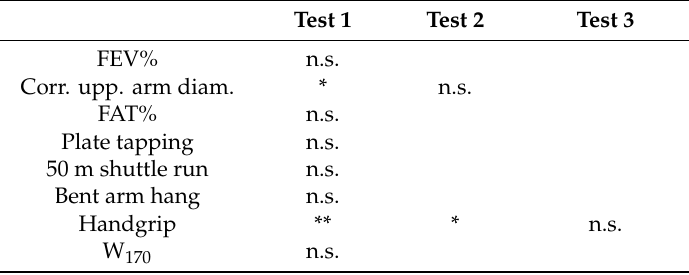
Table 2. Analysis of covariance of the eight hypotheses [6].